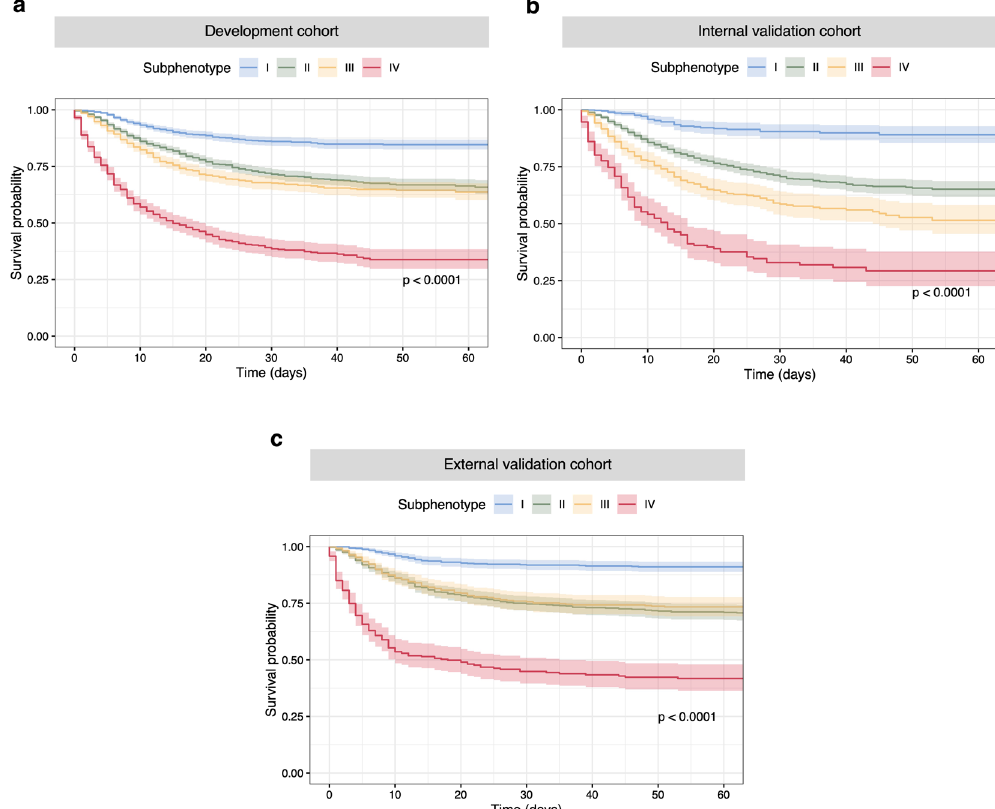
Fig. 3 Kaplan – Meier (KM) plots for 60-day mortality by subphenotypes. The survival probabilities were shown with 95% con fi dence interval. X -axis denotes time (days) after COVID-19 con fi rmation and Y -axis denotes the survival probability. a – c KM plots by subphenotypes in the development, internal validation, and external validation cohorts,